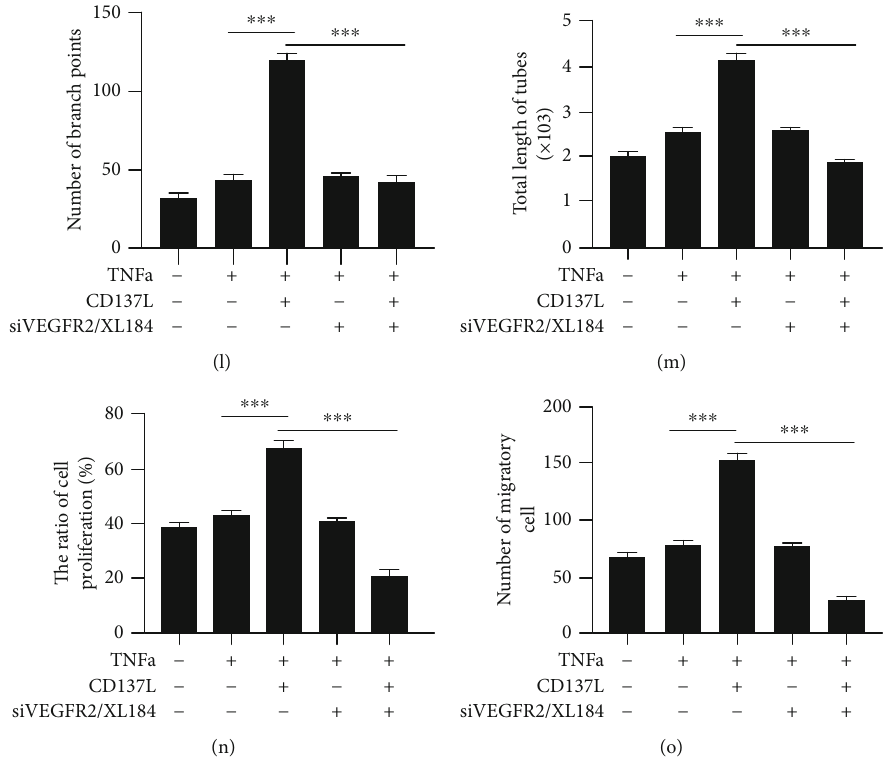
Figure 3: Silencing VEGFR2 impaired CD137 signaling-induced the Akt/eNOS pathway activation, endothelial cell proliferation, migration, and tube formation. (a, b) The protein expression of p-VEGFR2(Tyr1173) after treatment with VEGF165 (20 ng/mL) at 5, 10, 15, and 20 minutes. (c) The silencing e ffi ciency of CD137 VEGFR2-1,-2,-3 (50 nM) after treatment with VEGF165 (20 ng/mL) detected by western blot. (e) After stimulation with VEGF165 (20 ng/mL) for 5 minutes, the e ff ects of di ff erent concentrations of XL184 (cabozantinib, an inhibitor of VEGFR2 which was used in tube formation assay) at 0, 0.03, 0.3, 1, 5, and 10 μ M on p-VEGFR2(Tyr1173) were examined. (b, d, f) The protein relative expression level to β -actin. (g) Detection of p-VEGFR2(Tyr1173), p-Akt(Ser473), and p-eNOS(Ser1177) proteins after activating CD137 signaling by western blot after the CD137 activation for 10 minutes or/and inhibition of VEGFR2 with siVEGFR2. (h) The protein relative expression level of p-VEGFR2 (Tyr1173), p-Akt (Ser473), and p-eNOS (Ser1177) to total protein. (i) The tube formation of HUVECs after activation of CD137 alone or combined with inhibition of VEGFR2. The number of branch points and total length of tubes were observed under microscope and quanti fi ed by Image-Pro Plus 8.0; scale bar = 200 μ m (l, m). (j) The EdU-555 proliferation assay was used to detect endothelial proliferative ability after activation of CD137 signaling for 3 hours(n); red and blue fl uorescence represent the proliferating cells and nuclei, respectively. (k) Endothelial cells were cultured in 24-well transwell plates (pore size: 8 μ m) for 12 hours after treatments, and transwell assay was applied to detect endothelial migratory ability (o); the violet color represents migrating cells stained with 0.1% crystal violet. The numbers of proliferative and migratory ECs were analyzed with Image-Pro Plus 8.0 (n, o). ∗∗∗ p < 0 : 001 , scalebar = 20 μ m , n = 3